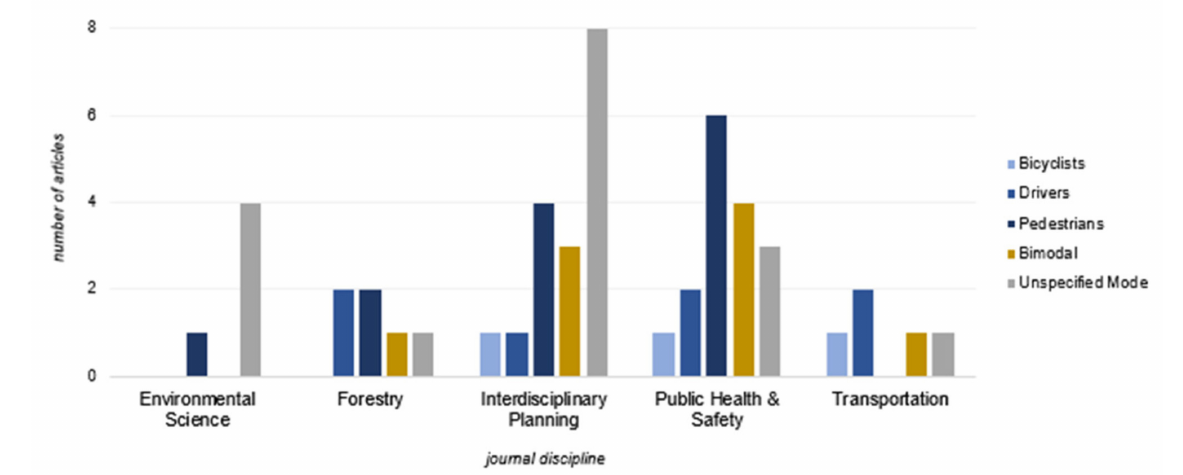
Figure 4. Disciplinary distribution by circulation mode studied.